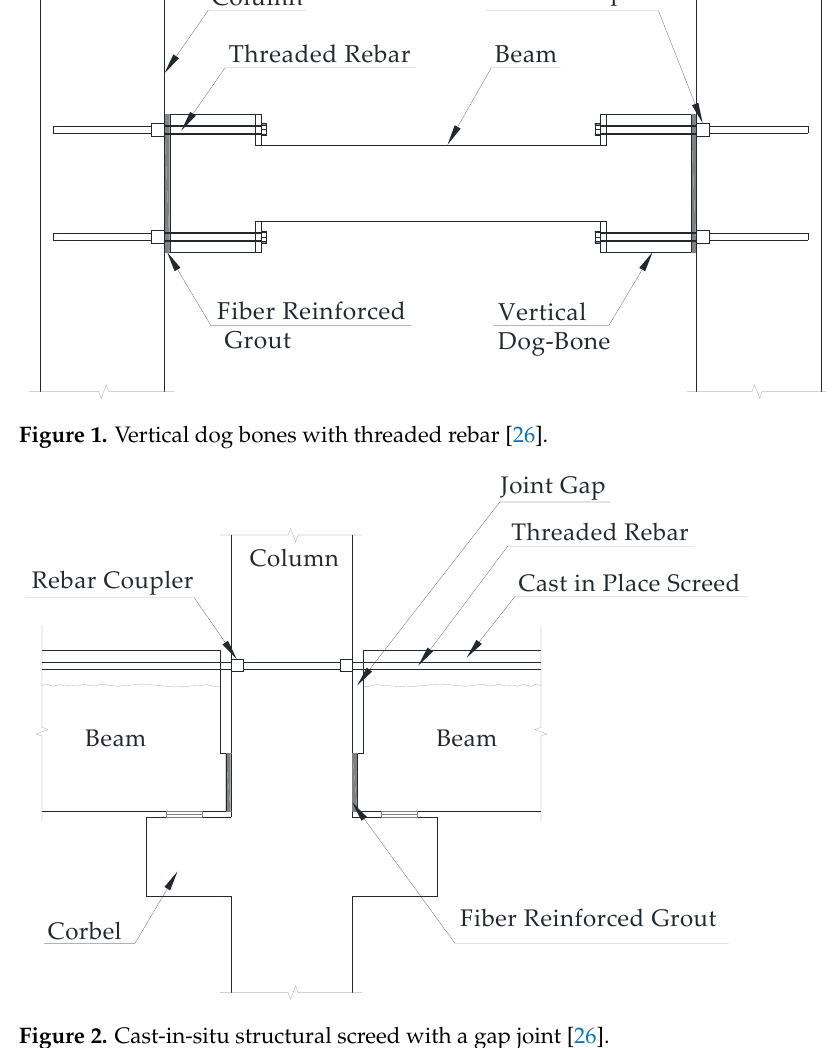
Figure 2. Cast-in-situ structural screed with a gap joint [26].